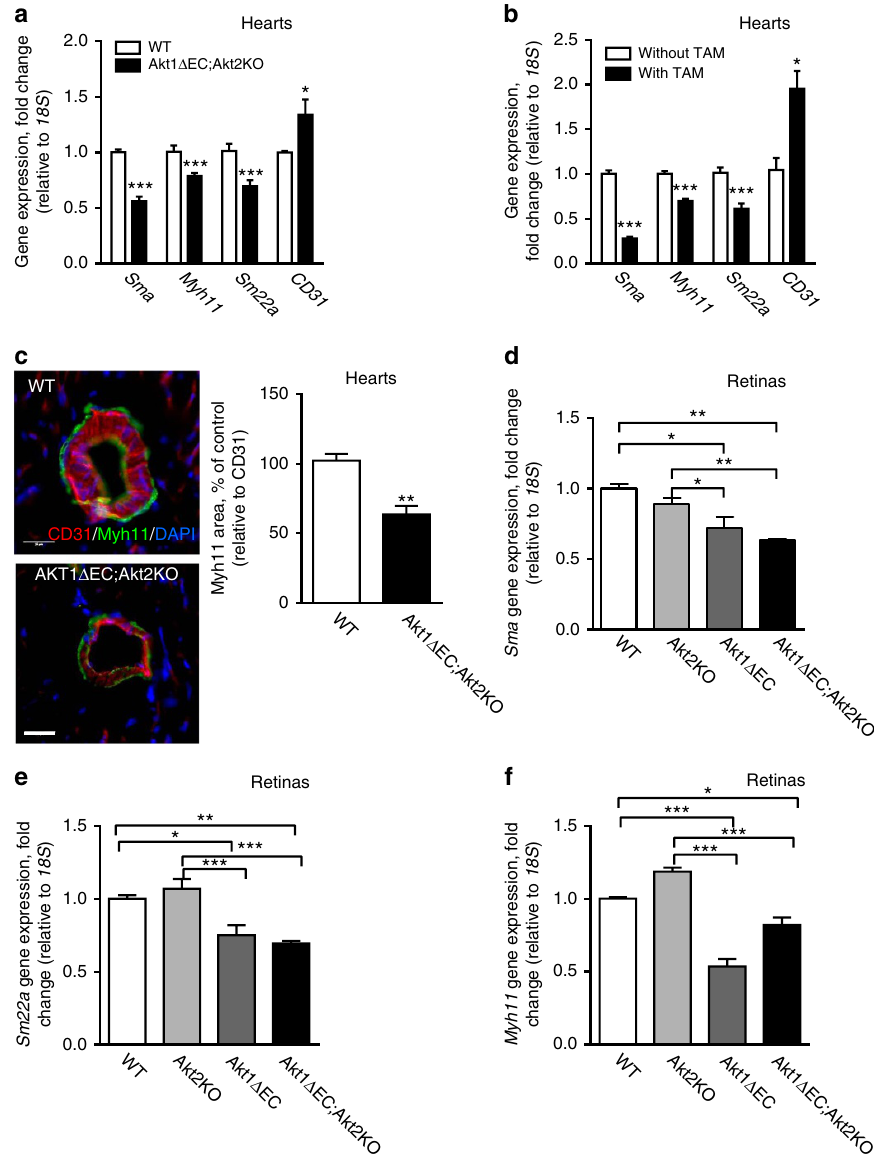
Figure 4 | VSMC de-differentiation and apoptosis. ( a ) Gene expression normalized to 18S in WTand Akt1 D EC;Akt2KO hearts after 4 weeks of tamoxifen treatment represented as mean fold change from WT ± s.e.m. ( n ¼ 4). ( b ) Gene expression normalized to 18S in Akt1 D EC;Akt2KO hearts from littermate mice with and without tamoxifen (TAM) treatment for 4 weeks represented as mean fold change from mice without TAM ± s.e.m. ( n ¼ 3). ( c ) Representative images of WT and Akt1 D EC;Akt2KO heart sections after 4 weeks of tamoxifen treatment stained for CD31 (red), Myh11 (green) and DAPI (blue), and quantification of the CD31/Myh11 staining ratio represented as mean ± s.e.m. ( n ¼ 3). Scale bar, 25 m m. ( d ) Myh11 gene expression normalized to 18S in WT, Akt2KO, Akt1 D EC and Akt1 D EC;Akt2KO retinas from mice after 4 weeks of tamoxifen treatment represented as mean fold change from WT ± s.e.m. ( n ¼ 6). ( e , f ) Sma and Sm22a gene expression normalized to 18S in WT, Akt2KO, Akt1 D EC and Akt1 D EC;Akt2KO retinas from mice after 4 weeks of tamoxifen treatment represented as mean fold change from WT ± s.e.m. ( n ¼ 6). ( g ) Representative images of WT and Akt1 D EC;Akt2KO heart sections after 10 weeks of tamoxifen treatment stained for CD31 or SMA (red), cleaved caspase 3 (green) and isolectin or DAPI (blue). Scale bar, 19 m m. ( h ) Quantification of the cleaved caspase 3-positive area per cell represented as mean ± s.e.m. ( n ¼ 3). * P o 0.05, ** P o 0.01 and *** P o 0.005 by Student’s t -test ( a – c ) or one-way analysis of variance ( d – f